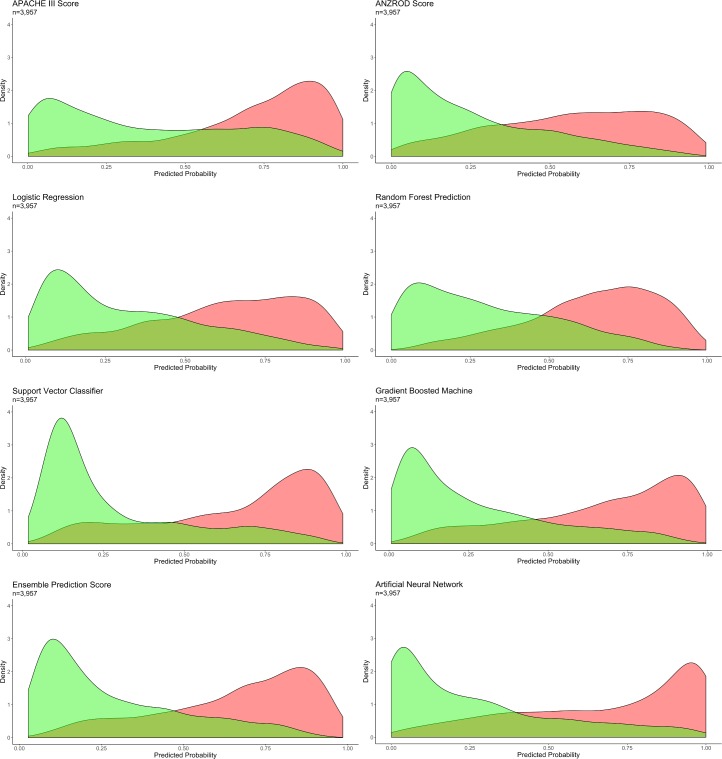
Probability curves for each model.Survivors indicated in green, and non-survivors in red. p < 0.001 for ensemble versus other models. ANZROD, Australian and New Zealand Risk of Death.